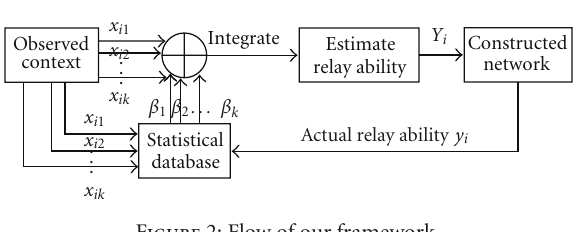
Figure 2: Flow of our